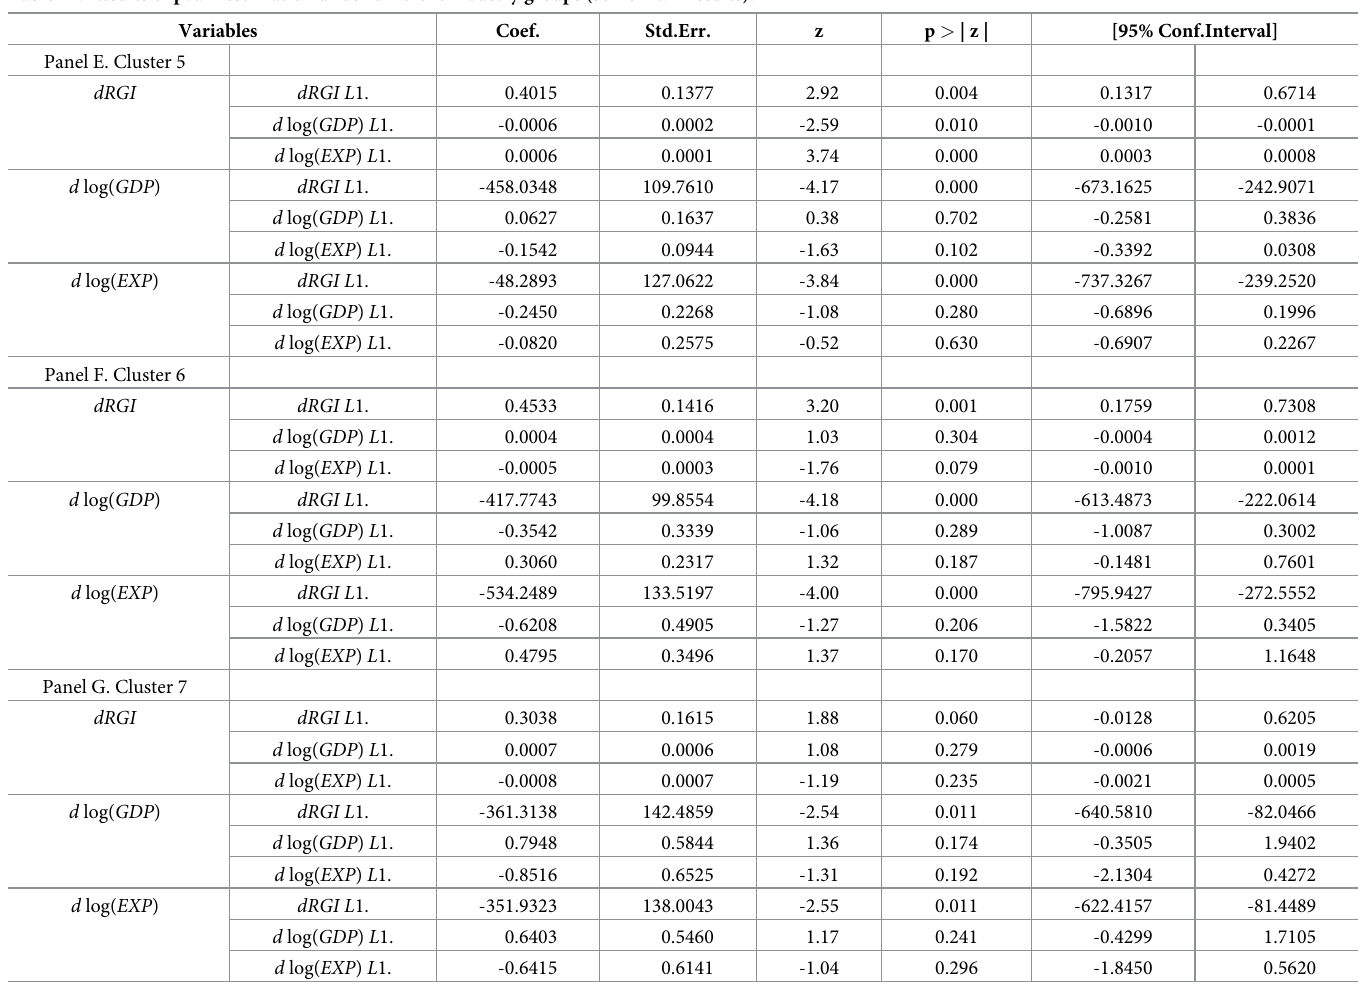
Table 11. Results of pvar2 estimation under different industry groups (some main results). Variables